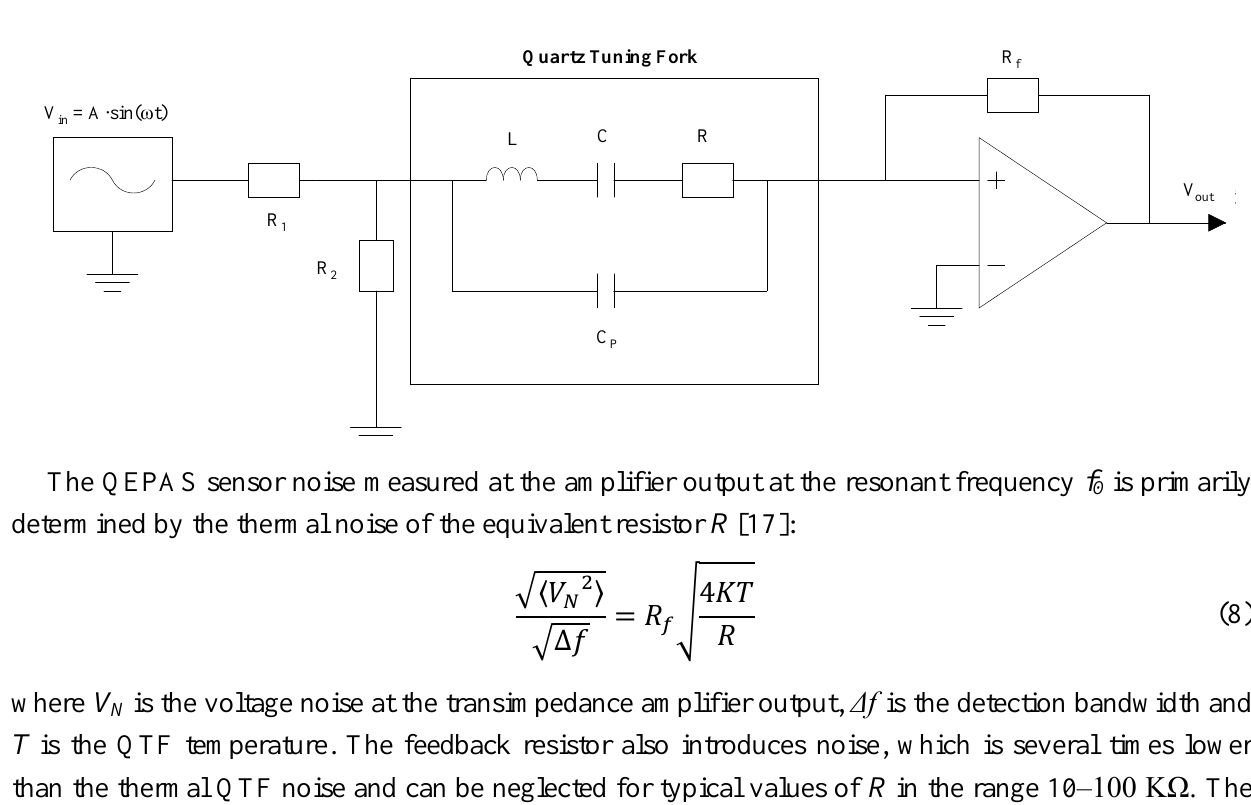
Figure 3. Schematic of the circuit used to characterize a